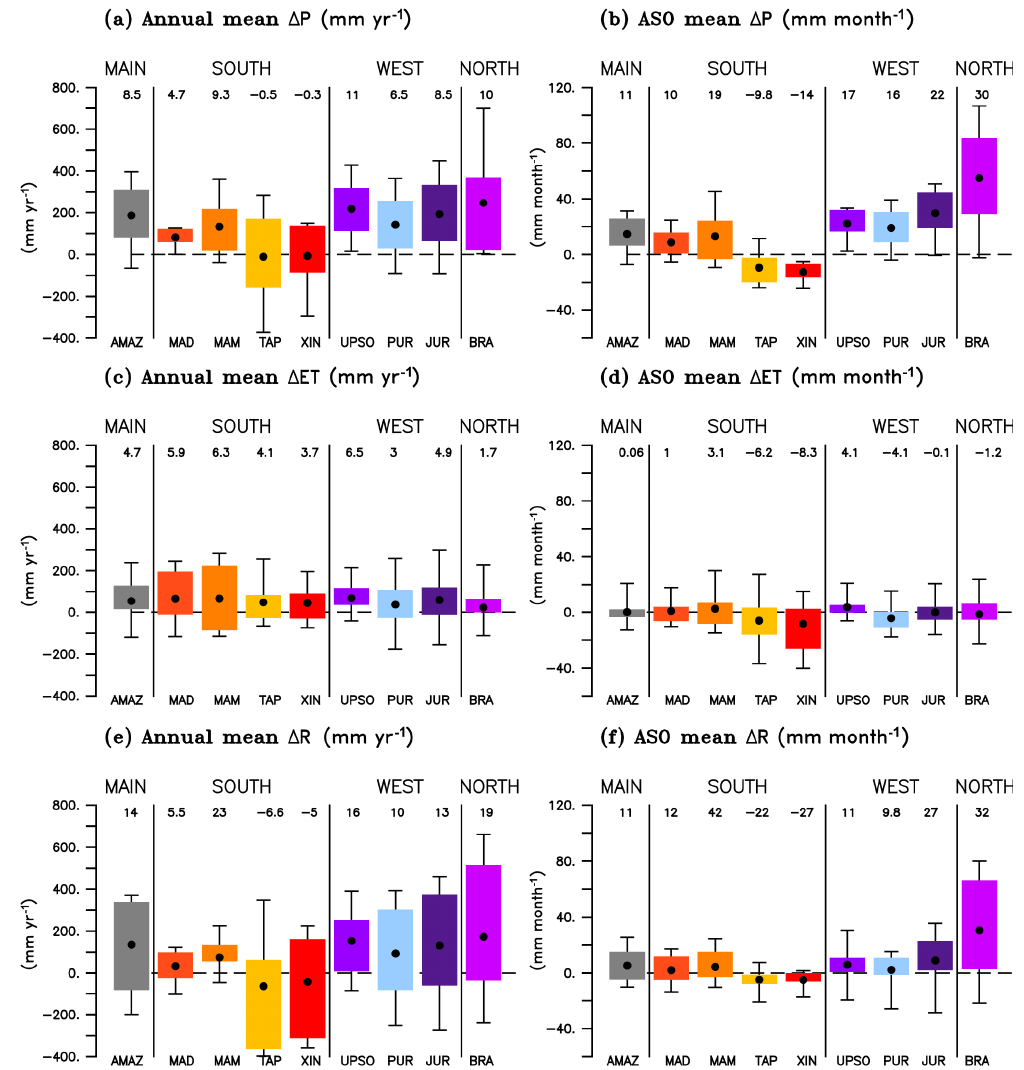
Figure 3. Changes in mean annual (mmyr − 1 ) and August to October (ASO) values (mmmonth − 1 ) of (a, b) precipitation, (c, d) ET and (e, f) runoff due to climate change only, for the end of the century, over the Amazon Basin and eight of its catchments (the abbreviations of the catchments are indicated in Table S1). Each box plot corresponds to the interquartile range (IQR, distance between the 25th and the 75th percentiles) within each catchment, indicating the spread of the three GCM forcings (for (cid:49)P ) and three GCM forcings × three LSMs (for (cid:49) ET and (cid:49)R ) results (see Fig. 1 for colour code). For a given box plot, the black points denote the mean value over the catchment, the whiskers extend from the minimum value to the maximum one and the numbers above the box plot indicate the mean relative differences over the catchment